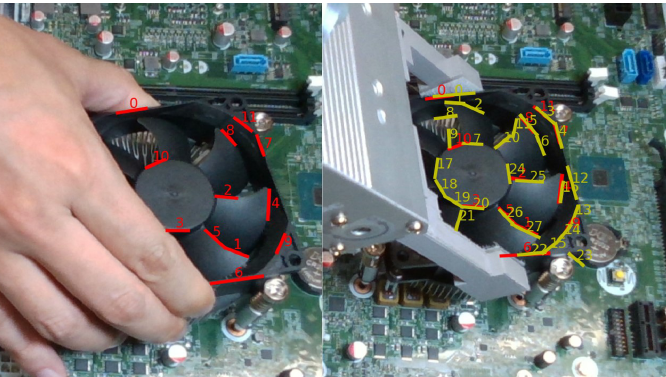
Figure 9. Transform the line segments in the target image ( left ) to the current image ( right ) with obtained R and t